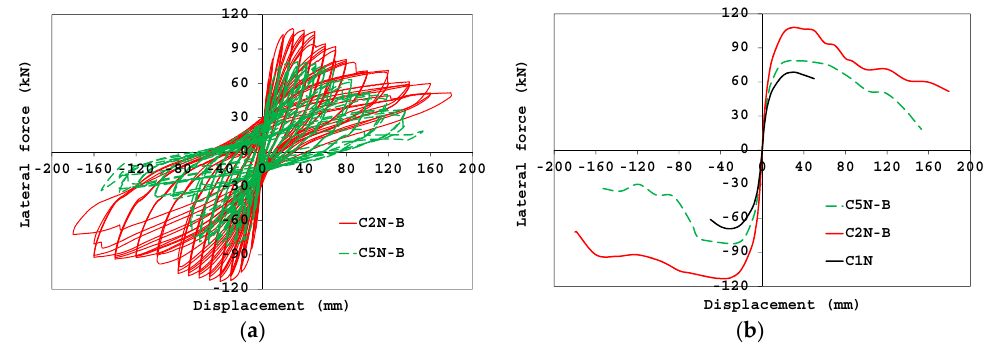
Figure 11. F ‒Δ hysteresis curves ( a ) and envelopes ( b ): columns C2N-B ( ν = 0.40) and C5N-B ( ν = 0.14).